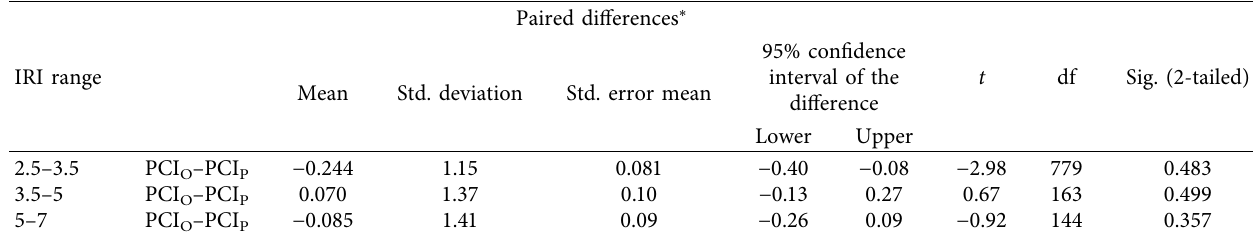
Table 4: T -test results for predicted and observed pavement condition index.